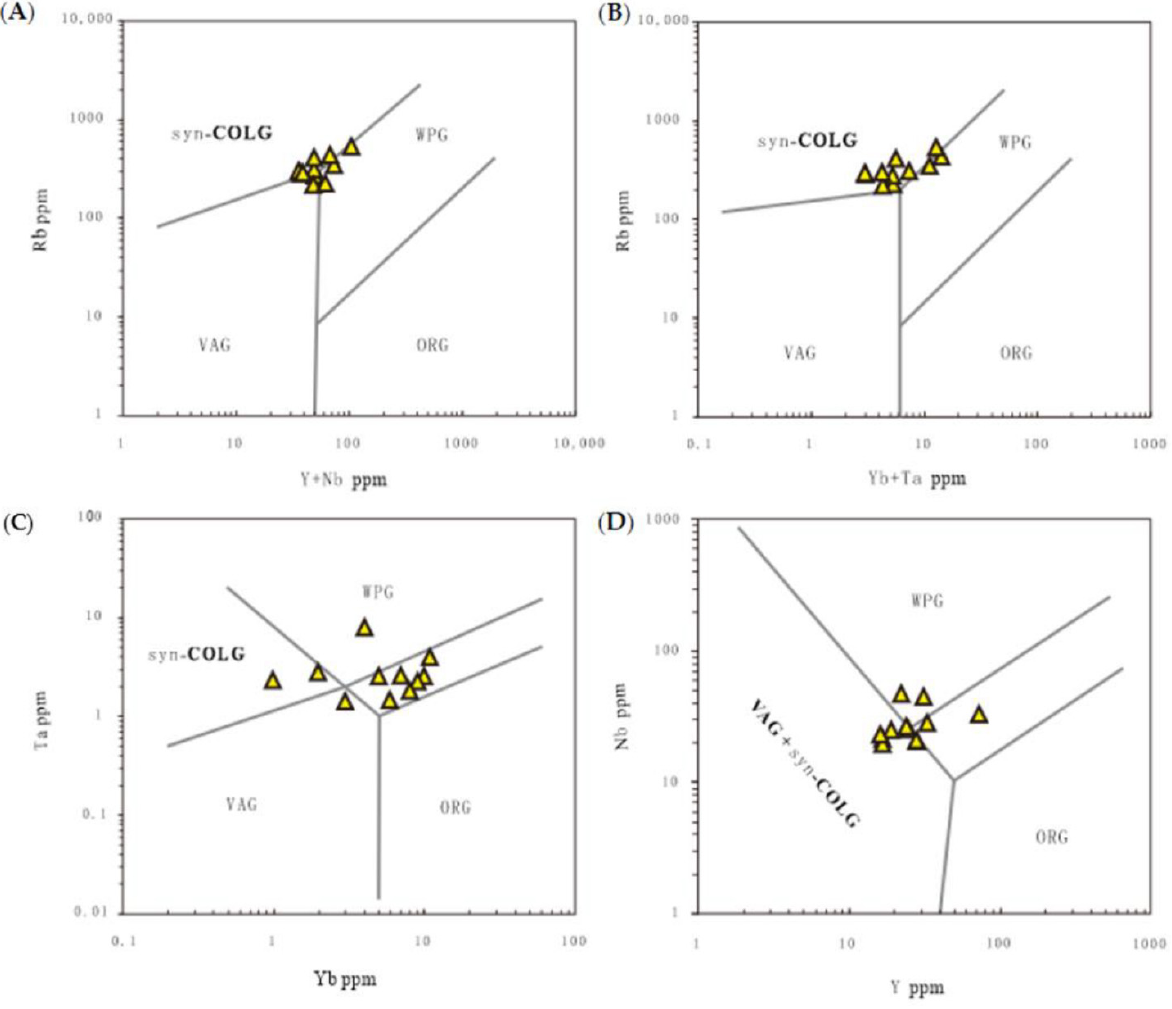
Figure 13. ( A ) Rb − (Y + Nb), ( B ) Rb − (Yb + Ta), ( C ) Ta − Yband ( D ) Nb − Y discrimination diagrams of granites (Pearce J A, [27]) VAG—volcanic arc granite; syn-COLG—syn collisional granite; WPG—within plate granite; ORG—ocean ridge